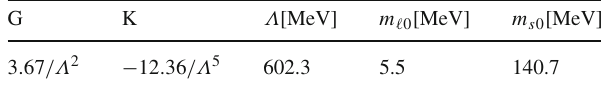
Table 2 Parameters of the NJL